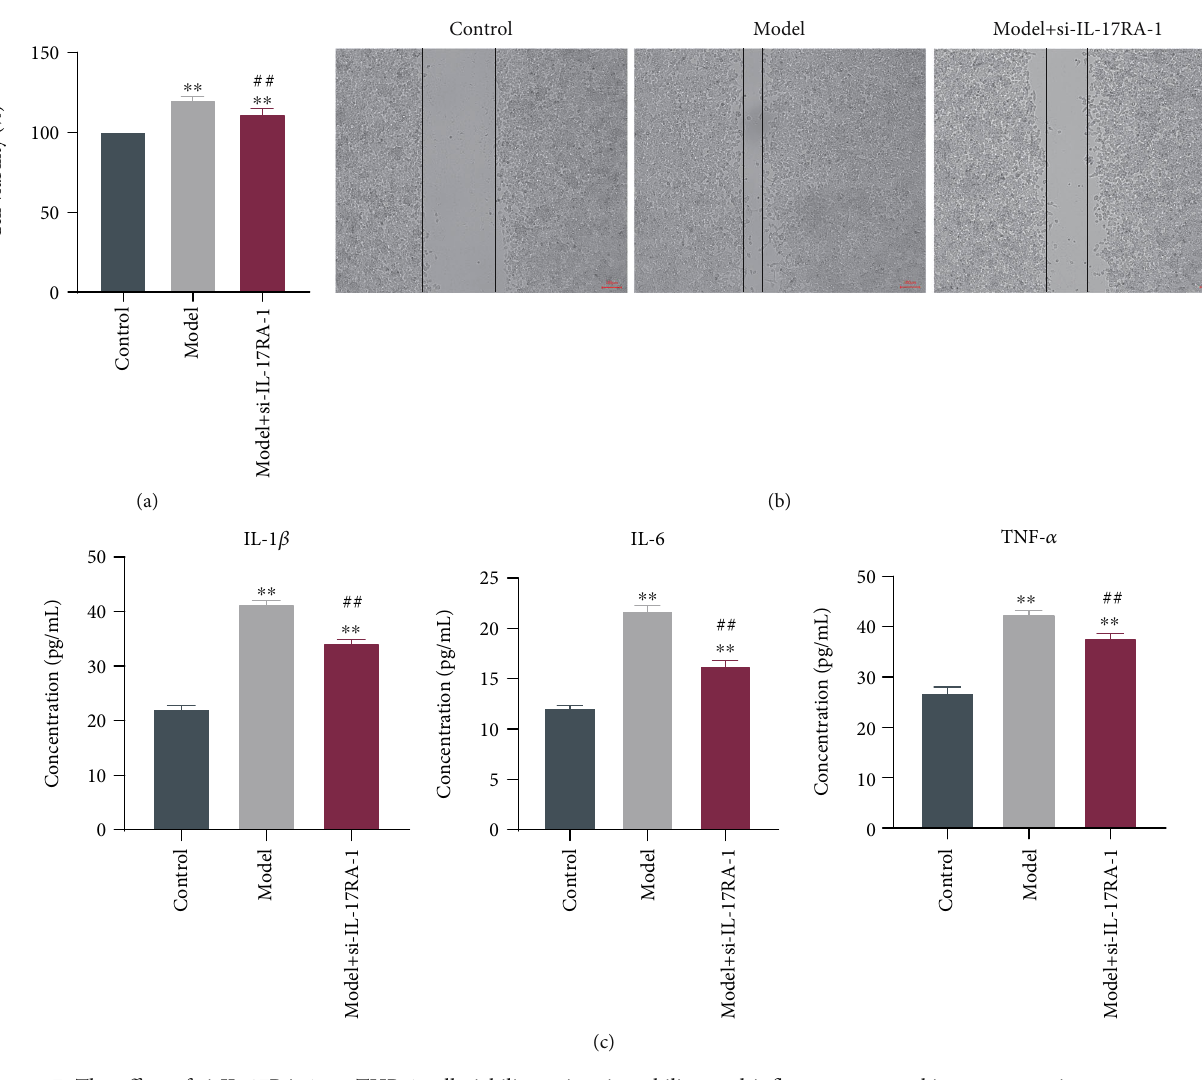
Figure 7: The e ff ect of si-IL-17RA-1 on THP-1 cell viability, migration ability, and in fl ammatory cytokines contents in supernatant. (a) CCK-8 detection of cell viability. (b) Scratch test detection of cell migration ability. Scale bar, 100 μ m. (c) ELISA test detection of IL-1 β , IL-6, and TNF- α contents in